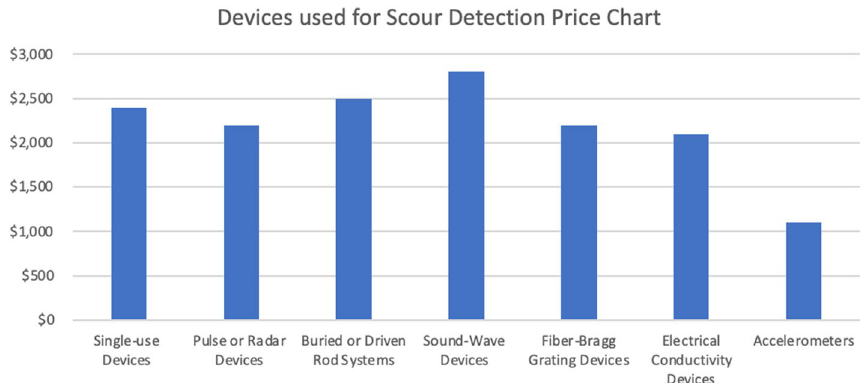
Fig. 8 Price chart per unit for devices used to monitor scour